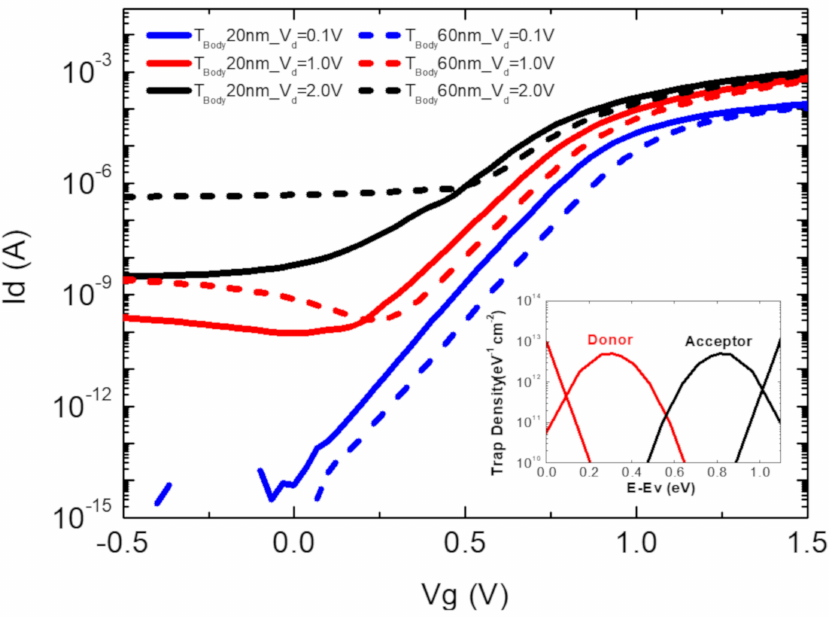
Figure 3. Id-Vg transfer curve of poly-Si 1T-DRAM cells (inset, the density of states in poly-Si 1T-DRAM).